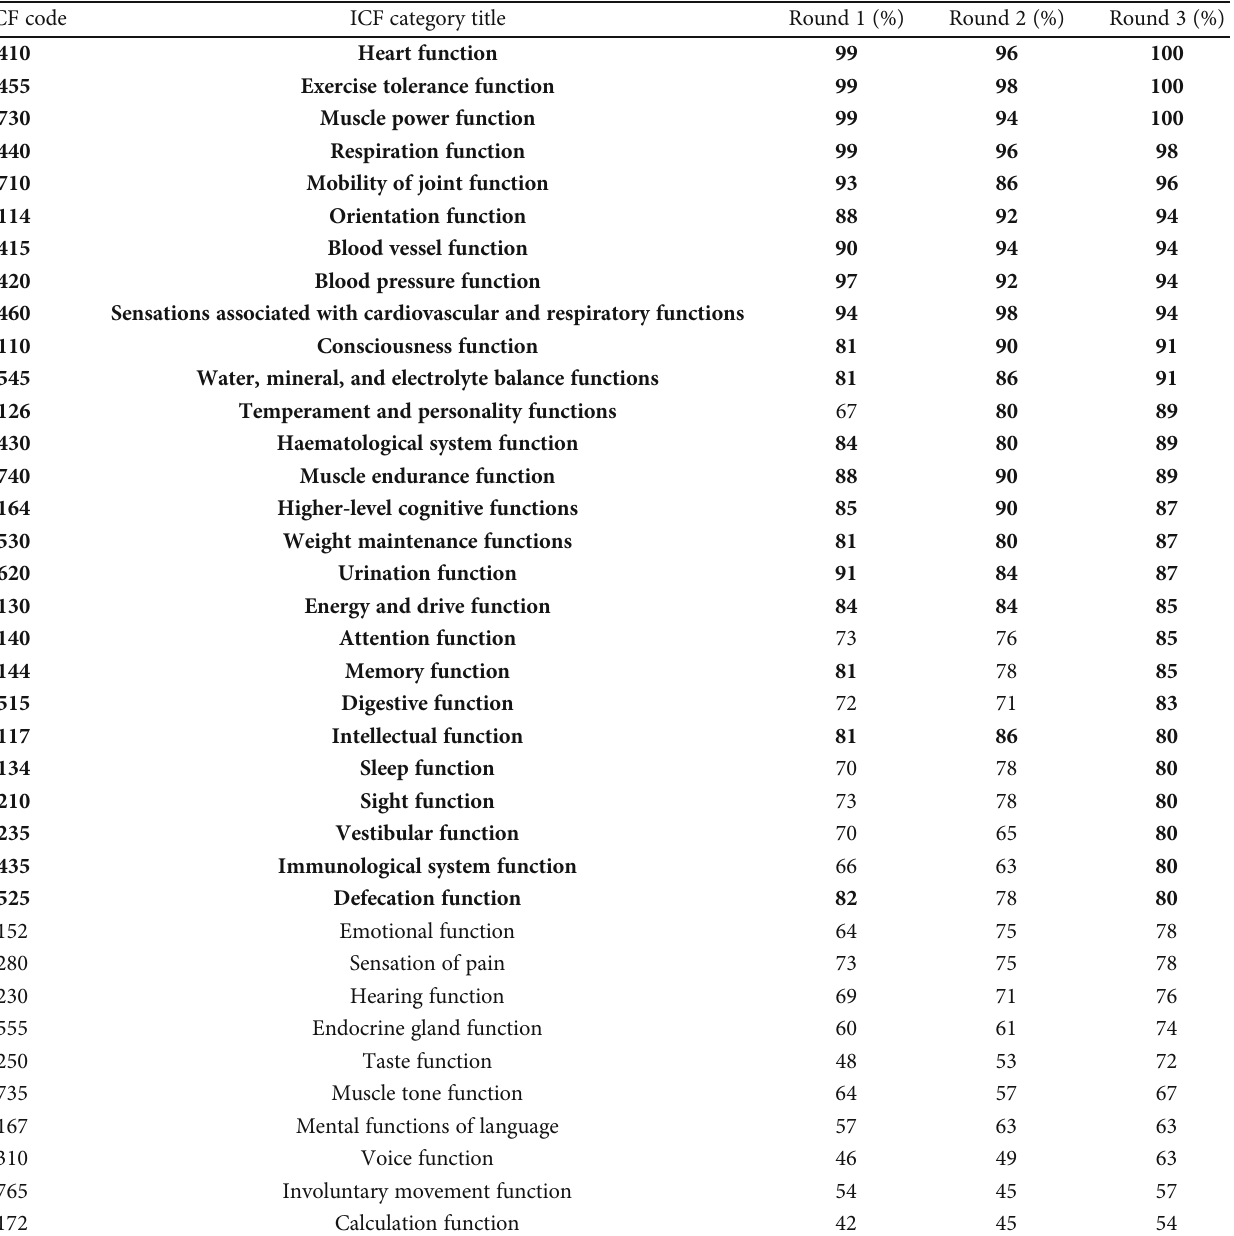
Table 3: International Classi fi cation of Functioning, Disability, and Health (ICF) body function categories that were considered relevant by ≥ 50% of participants in the third round (items in bold with ≥ 80%